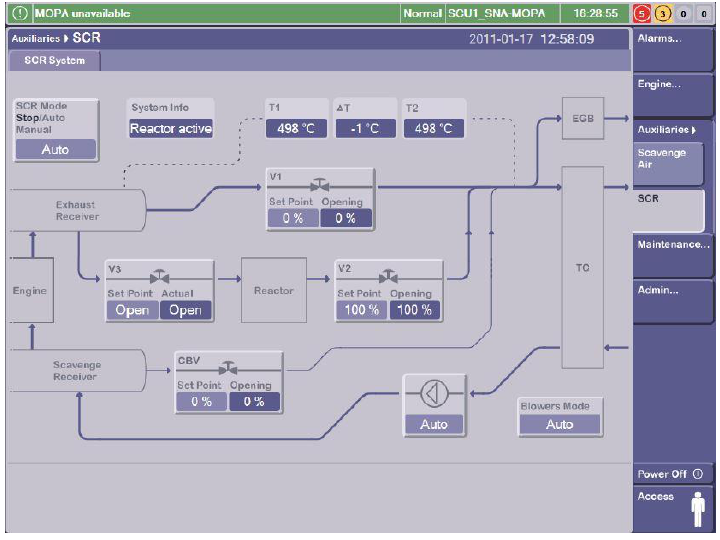
Figure 4. Control chart of the bypass valve group